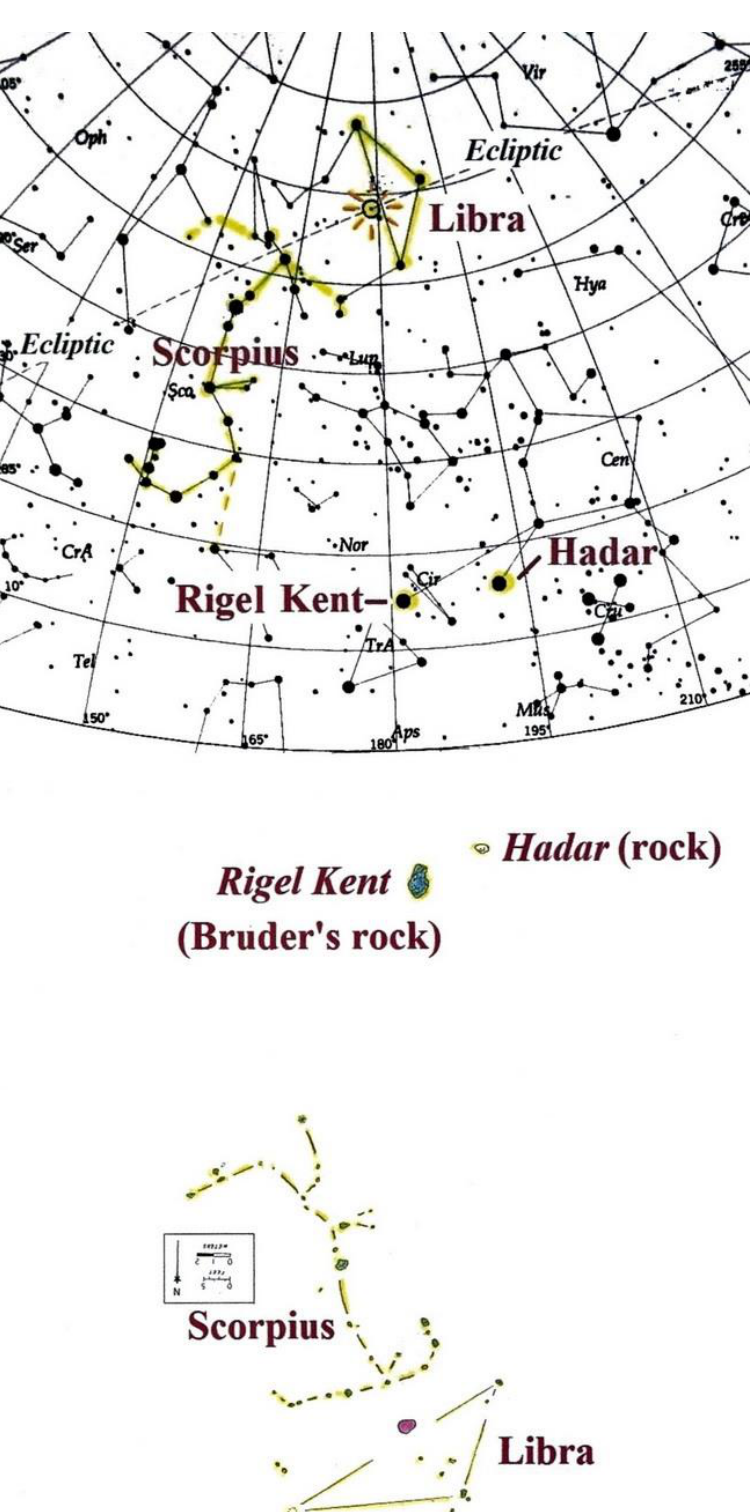
Figure 33. The stellar precession map (at top) shows the where the autumnal equinox sunrise would have been relative to the background of stars in Libra ca. 2000 BCE. Of note, the bright stars Rigel Kent and Hadar were at or near culmination near midnight during the time of the vernal equinox ca. 2000 BCE. The illustration (at bottom) is a map of the Star-Being with the two bison effigy rocks including Bruder’s Rock (see Figure 32). Both effigy rocks and the Star-Being are in an almost exactly mirrored or reflected location relative to Rigel Kent, Hadar and Scorpius in the night sky. The location of the Star-Being headstone likely indicates where the sun rose into Libra at the time of the autumnal equinox between 4000-2000 BCE, the proposed date of origin of the Star-Being and other petroforms found at the site (Bender